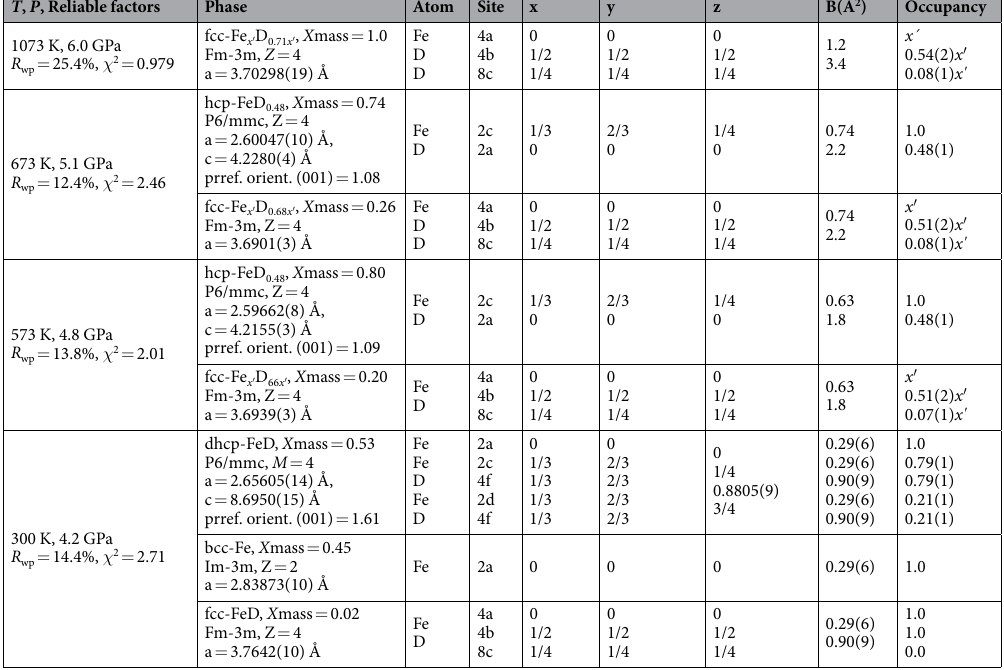
Table 1. Positional parameters ( x , y , z ) and site occupancies for iron deuterides; X mass: mass fraction, Z: number of formula units per unit cell, B: atomic displacement